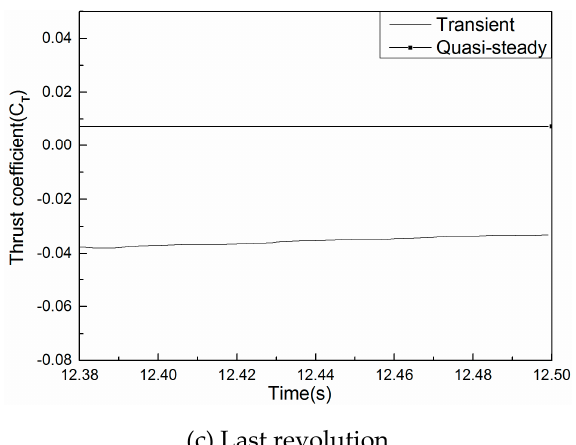
Figure 11. An amplified local view of the time history of the rotor thrust coefficient within one revolution. ( a ) Initial revolution; ( b ) Mid-term revolution; ( c ) Last revolution.